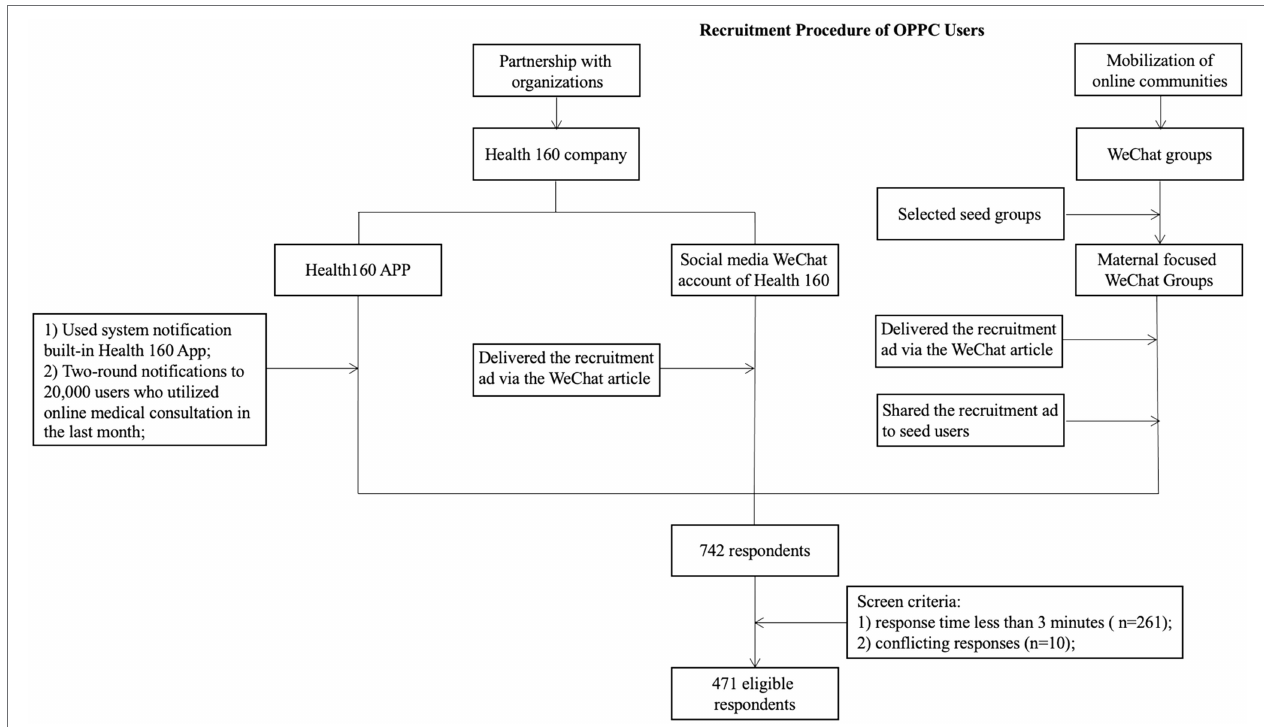
FIGURE 1 | Participant recruitment